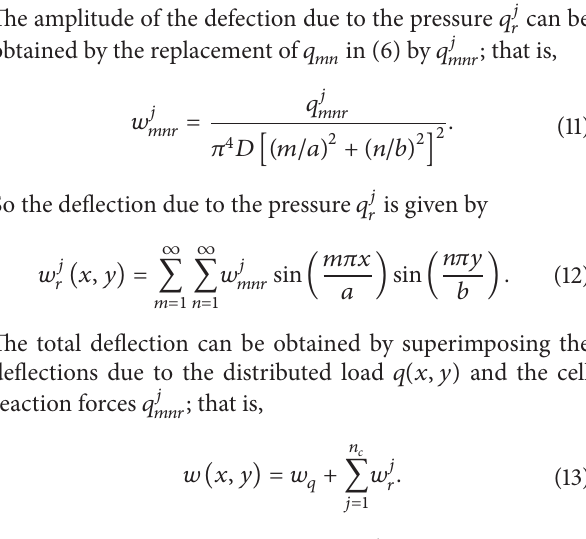
Figure 3: Dividing of the support to cells in a simply supported rectangular